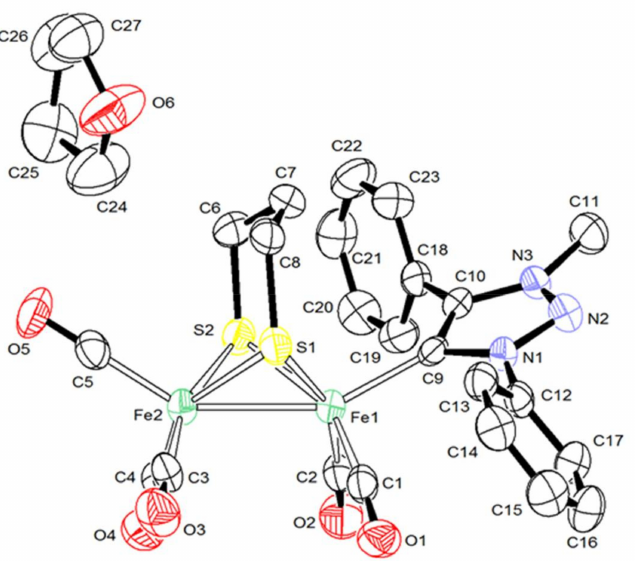
Figure 1. Ortep view (ellipsoids at 30% of probability level) of 1.C 4 H 8 O . Selected distances